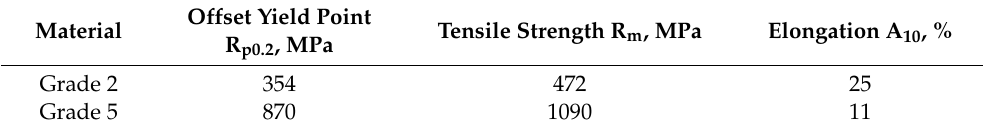
Table 1. Nominal chemical composition of Grade 2 and Grade 5 titanium. Table 2. Mechanical properties of analyzed sheets.